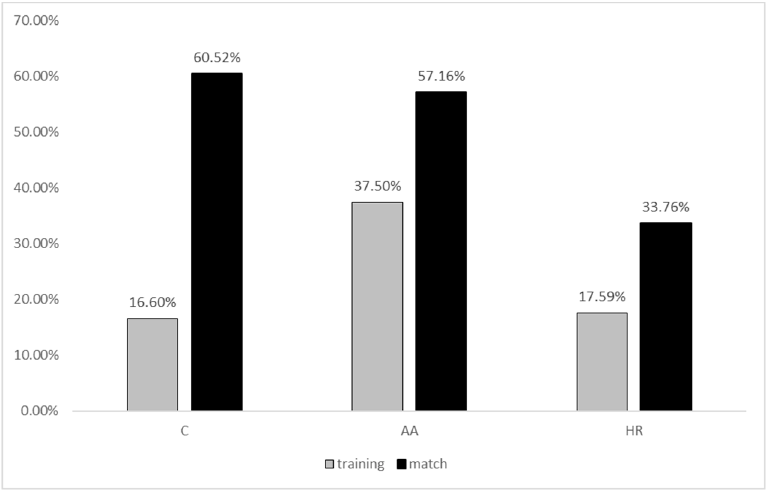
Figure 1. Pre-competitive effect: training and match increase compared with the baseline values presented as percentages (%). Table 1. Differences between matches and training sessions; results calculated by Mann–Whitney U test and magnitude of differences presented as Cohen’s d .